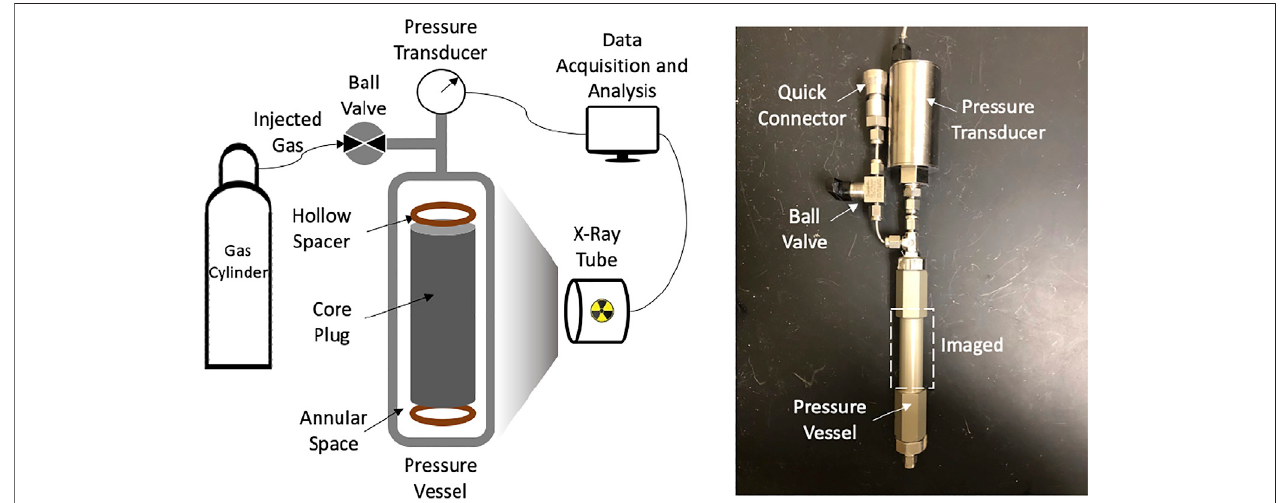
FIGURE 1 | Schematic of the experimental setup for gas invasion experiment in conjunction with micro-CT imaging (left) and the actual experimental setup (right). The dashed box indicates the approximate position that is imaged.